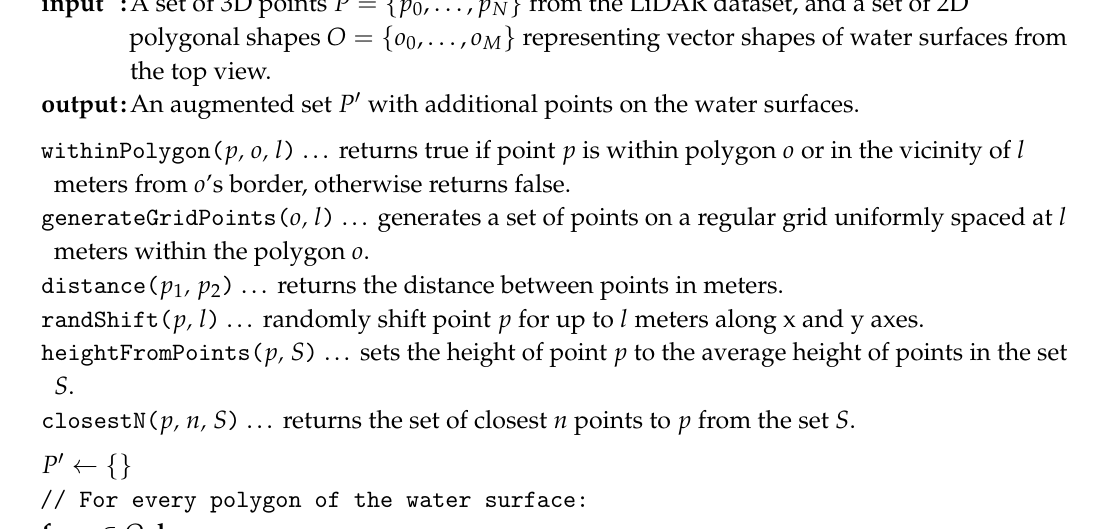
Algorithm 1: Water surface reconstruction